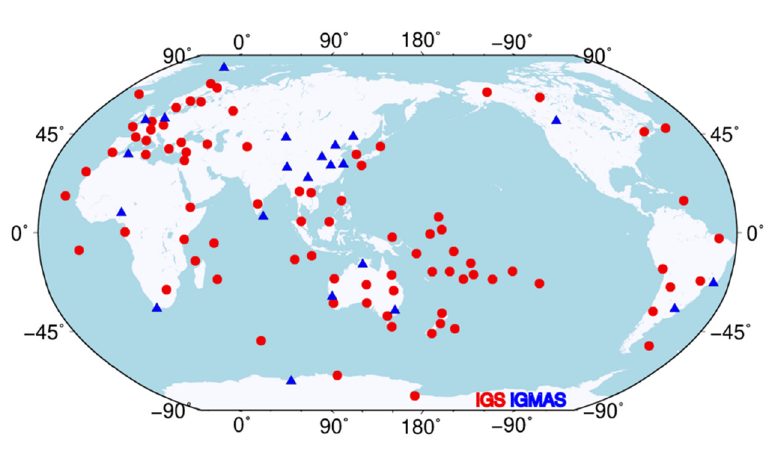
Figure 2. Distributions of the approximately 90 ground stations used in this study. Red circles indicate IGS MGEX stations. Blue triangles represent iGMAS stations. Table 2. Summary of the models and information used in this study.